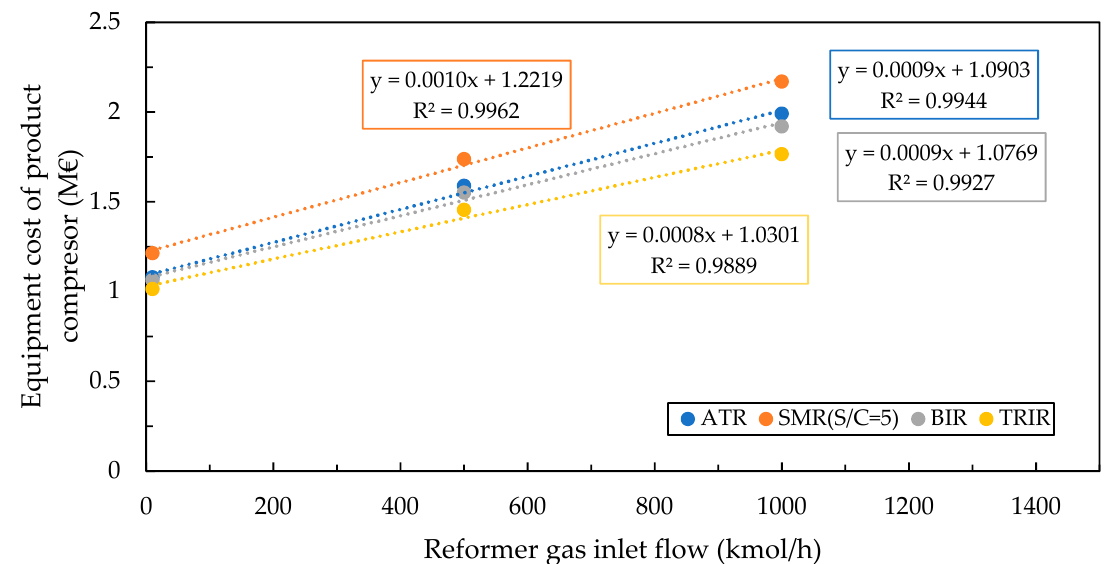
Figure 9. Economies of scale for product compressor from 22.2 bar to 70 bar.